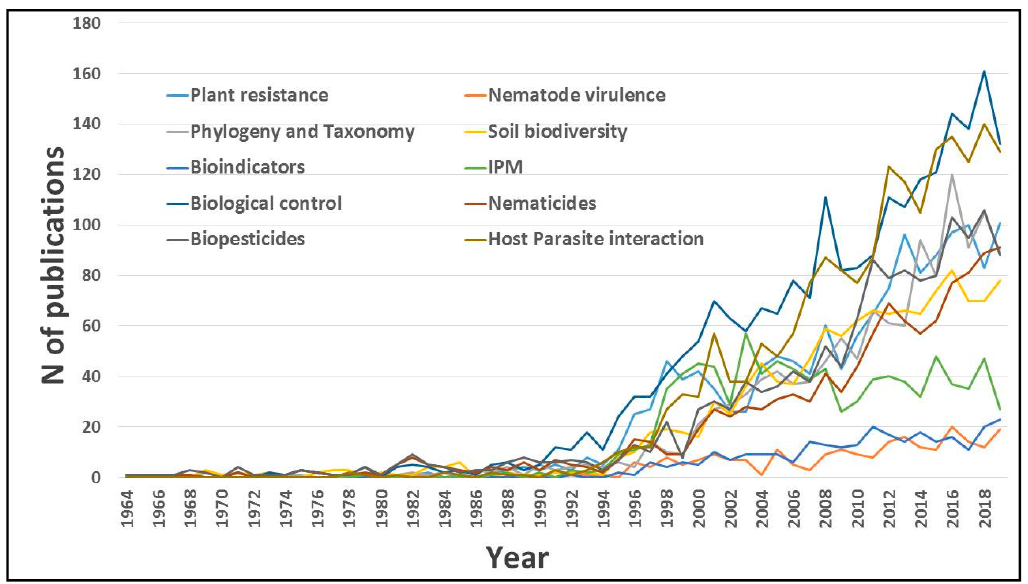
Figure 7. Trend of the main research lines on nematodes + plants through the 160 keywords.